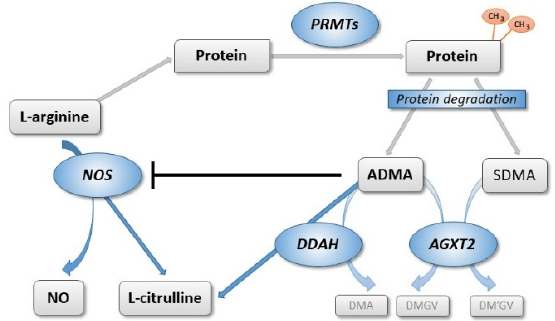
Figure 1. Schematic representation of biosynthesis and metabolism of asymmetric and symmetric dimethylarginine. L-arginine residues within specific proteins are subject to methylation by protein arginine N-methyltransferases (PRMTs). After protein hydrolysis, asymmetric (ADMA) and symmetric dimethylarginine (SDMA) are released. ADMA is a competitive inhibitor of nitric oxide synthases (NOS). ADMA, but not SDMA, is degraded by dimethylarginine dimethylaminohydrolases (DDAH1 and DDAH2) into L-citrulline and dimethylamine (DMA). Both dimethylarginines may be cleaved by an alternative pathway through alanine glyoxylate aminotransferase 2 (AGXT2), resulting in the formation of symmetric or asymmetric dimethylguanidinovaleric acid (DMGV and DM’GV). Figure reproduced with permission from [30] under CC BY-NC (SAGE Publishers).